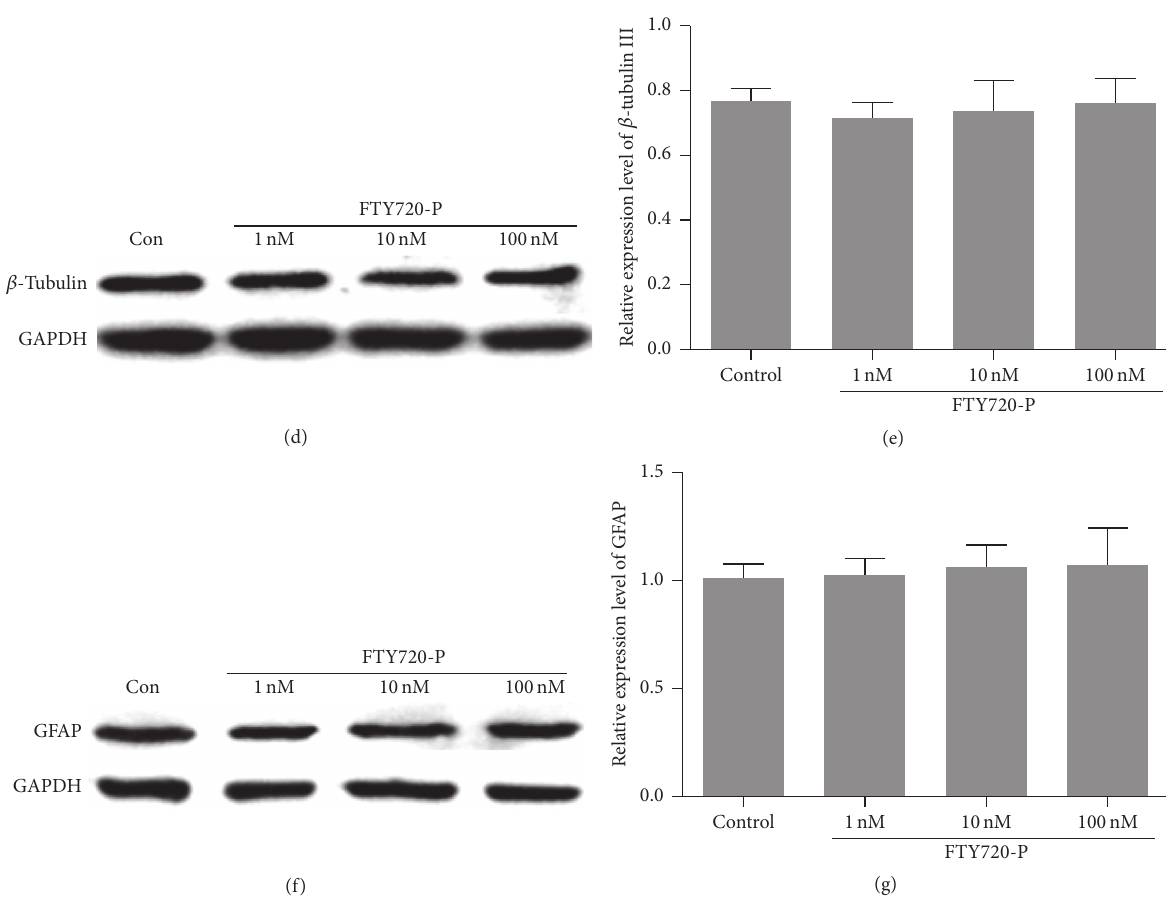
Figure 3: Differentiation of NSCs into neurons and astrocytes in the presence of FTY720. (a) Representative images of neurons ( 𝛽 -tubulin III positive, in green) and astrocytes (GFAP positive, in red) in different groups. Bar = 80 𝜇 m. Arrows indicate protoplasmic astrocytes. ((b)-(c)) Quantification of the proportion of differentiated neurons and astrocytes. 𝑛 = 5 . ((d)-(e)) Western blot analysis of 𝛽 -tubulin III protein in different groups. 𝑛 = 3 in each group. ((f)-(g)) Western blot analysis of GFAP protein in different groups. 𝑛 = 3 in each group. ∗ 𝑃 < 0.05 compared with control group; # 𝑃 < 0.05 compared with 1nM FTY720 group, by ANOVA followed by Dunnett’s multiple comparison